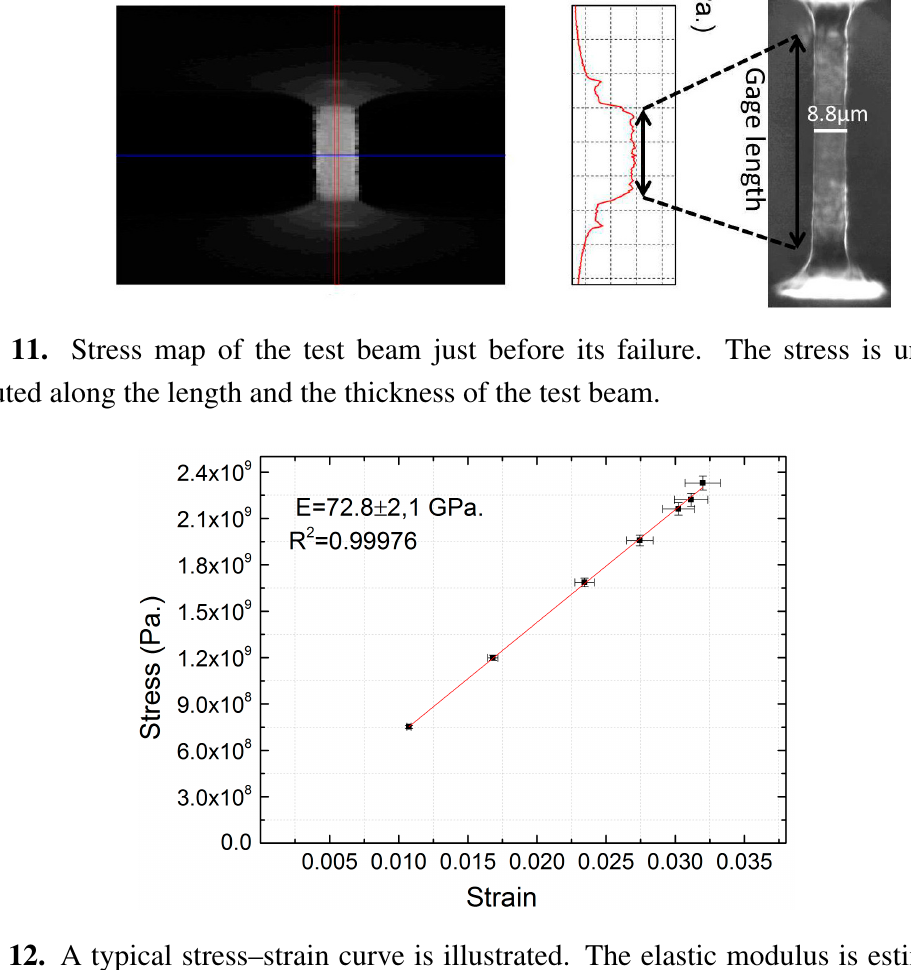
Figure 12. A typical stress–strain curve is illustrated. The elastic modulus is estimated at 72.8 GPa with a relative error of 2.1 GPa.